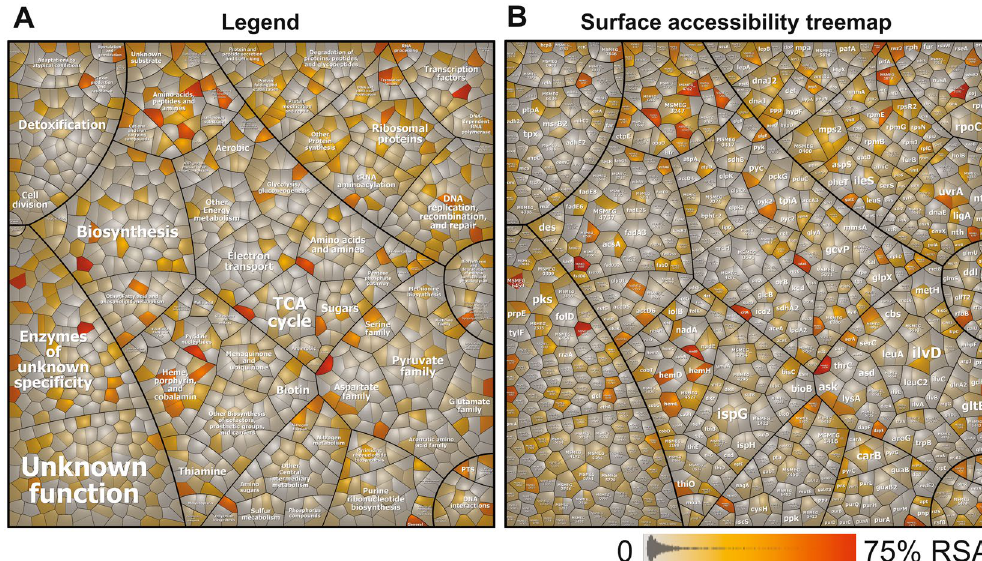
Figure 7. Relative surface accessibility (RSA) treemap of Cys residues identified in the redox proteome of M . smegmatis using OxICAT. The surface accessibilities of Cys residues were predicted using the NetSurfP server ver. 1.1 http://www.cbs.dtu.dk/services/NetSurfP/. The RSA treemap is composed of 1332 Cys residues identified in the redox proteome of the M . smegmatis wild type and the mshC mutant. Proteins are classified according to the M . smegmatis TIGRfam annotation. The treemap in ( A ) serves as legend for the functional classification of the proteins shown in the treemap in ( B ). The cells in the treemap represent Cys residues that are color-coded according to their relative surface accessibilities (RSA) with a white-orange-red color gradient ranging from 0–75% RSA. Exposed Cys are orange and buried Cys are shown in white-grey. In total, about 180 Cys residues (13.5%) in 163 proteins have a RSA value of > 20% indicating that a majority of Cys residues are not surface-exposed in the predicted secondary structure of the